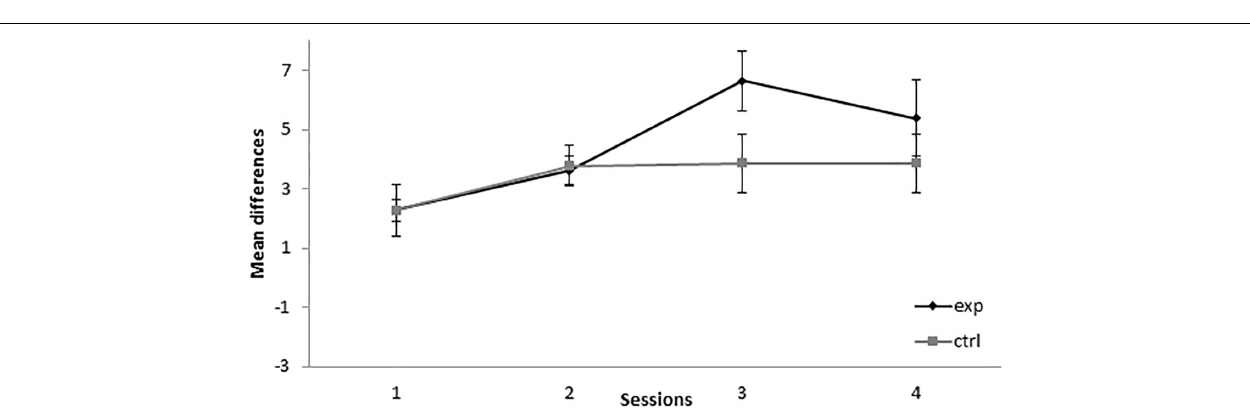
FIGURE 2 | Retardation test in Experiment 1. PreX-X differences ( ± SEM), averaged for the 10 X+ presentations per session in the retardation test, are displayed. The black line represents the group that was trained with 14 A+, two AX – , 12 F – , and two X – presentations per session in conditioning. The gray line represents the group that was trained with 14 A+, two BX, 12 F – , and two X – presentations per session. In the retardation test, both groups received 10 X+ presentations per